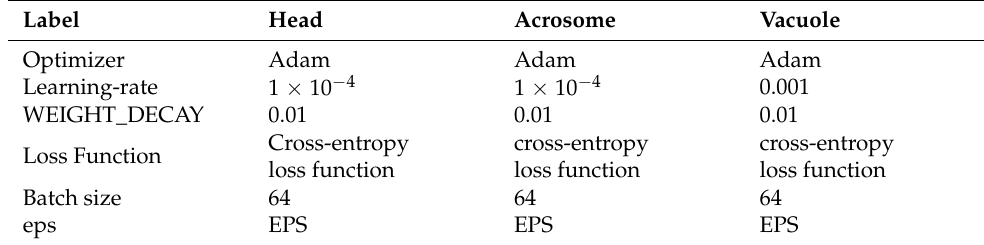
Table 5. Details of hyperparameters for proposed